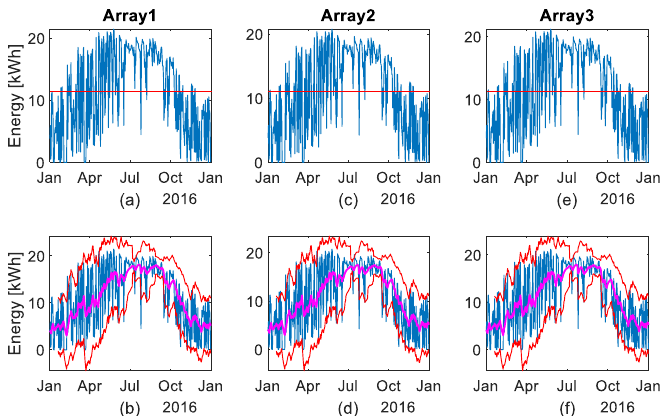
Figure 9. ( a ) Energy produced by array #1 in twelve months and its mean value as red line; ( b ) upper and lower BB 20 of array #1 in red color, and EMA 20 in magenta color. ( c ) and ( d ) refer to array #2. ( e ) and ( f ) refer to array #3.